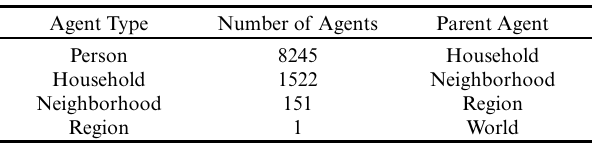
Table 1 . Agents types in the Chitwan agent-based model. “Parent agent” is the agent at the next higher level in the